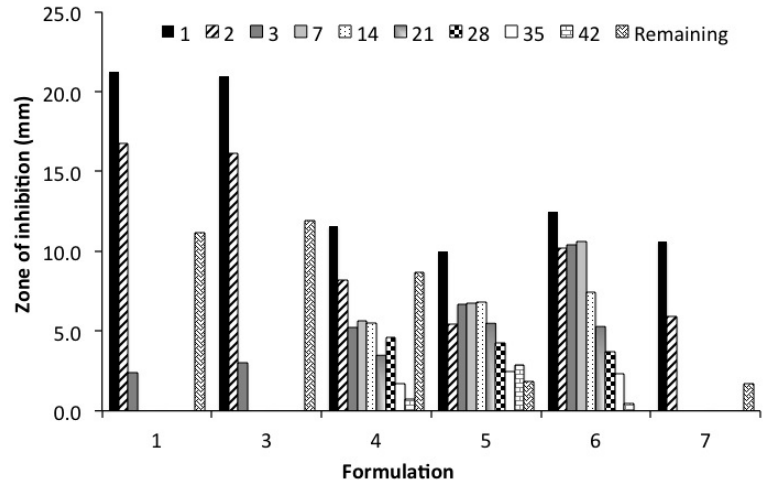
Figure 6. The bioactivity of released vancomycin was determined via a Kirby Bauer zone of inhibition study. Release studies were done for six weeks. At the conclusion of the study, the remaining drug was extracted from the putty. Bioactivity was seen throughout the experimental time course in formulations 4–6.